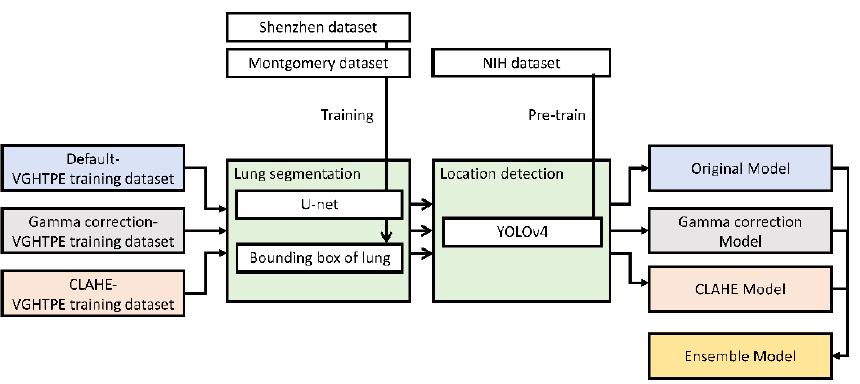
Figure 5. Training pipeline of the lung nodule detection